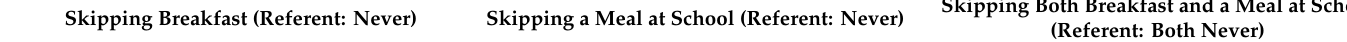
Table 4. Association of skipping breakfast and / or a meal at school with socioeconomic correlates, nutrition knowledge, and lifestyle in teenagers. (Adjusted odds ratios and 95% confidence intervals; multivariate